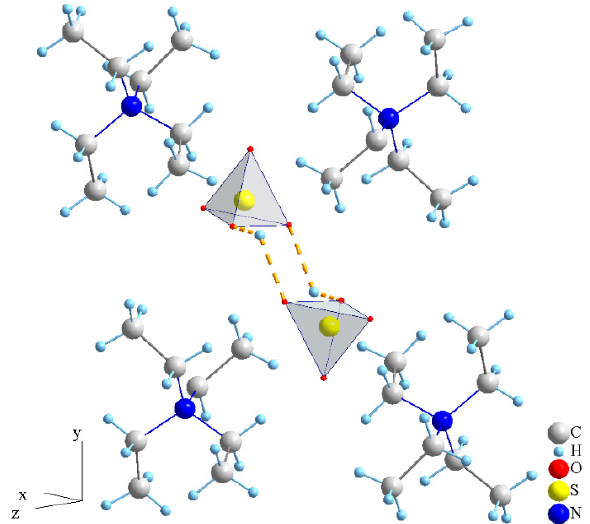
Figure 1. Schematic presentation of Et 4 NHSO 4 crystal structure according to [26]. Et 4 N + cations have the shape of a Nordic cross with S 4 symmetry and are much larger than the anions. The symmetry of SO 4 groups is close to tetrahedral, with small deviations in the O-S-O angle from 109.28 ◦ for an ideal tetrahedron. Two sulfate tetrahedra are linked into dimers by strong hydrogen bonds. The dimers are ordered into layers that are isolated from each other at a relatively large distance of 6.53 Å [26]. At T = 160 ◦ C, the tetragonal phase I4 1 /acd is formed with the unit cell parameters a = 14.0430 Å and c = 25.686 Å and exists up to the melting point of Et 4 NHSO 4